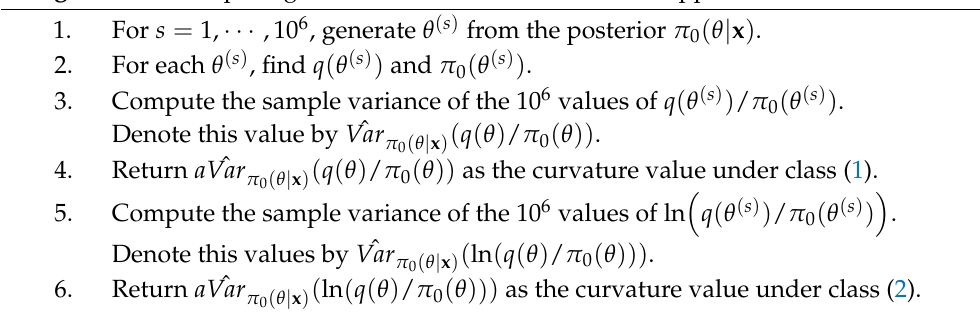
Algorithm 1 Computing curvature based on Monte Carlo